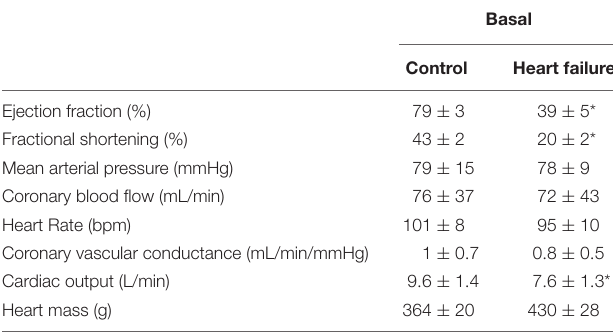
TABLE 1 | Resting values for hemodynamic parameters between conscious normal and heart failure sheep.